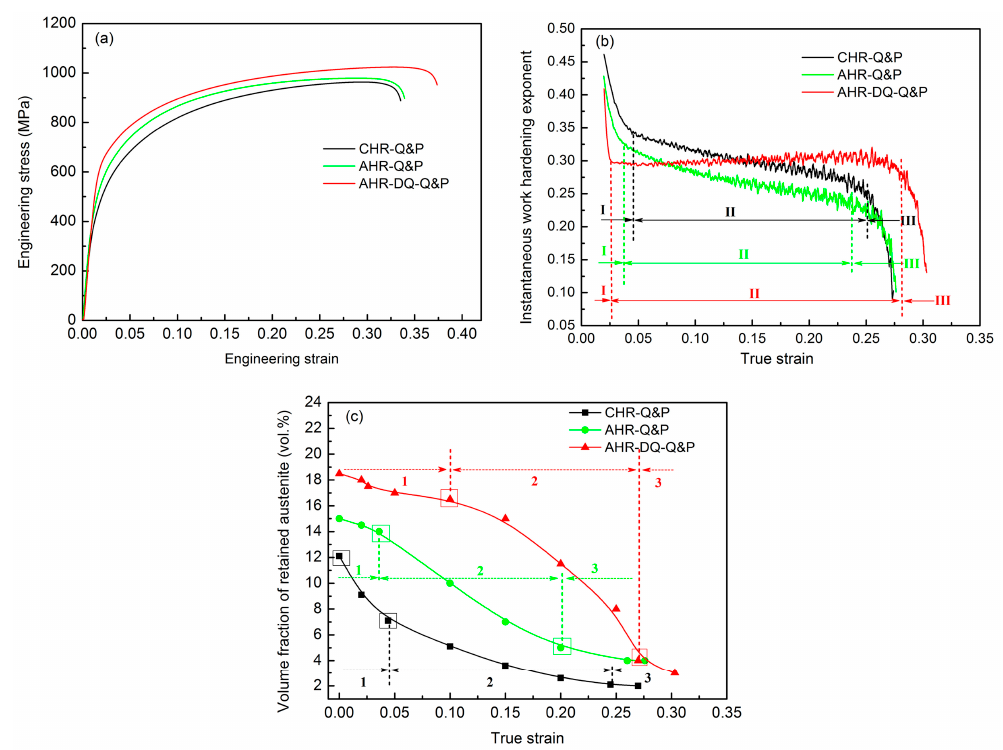
Engineering stress-strain curves of samples at room temperature ( a ), variation in instantaneous work-hardening exponents with true strain ( b ) and volume fraction of retained austenite as a function of engineering strain ( c ) for CHR-Q&P, AHR-Q&P and AHR-DQ-Q&P steel.